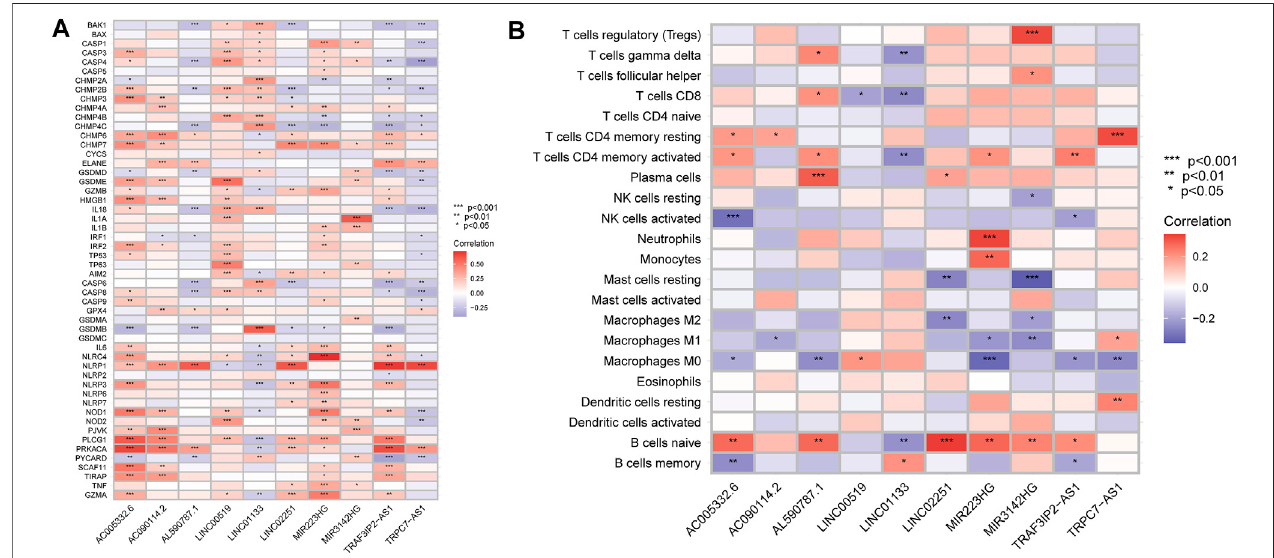
FIGURE9| Correlationanalysis. (A) CorrelationofPRlncRNAsandPRGs. (B) CorrelationofPRlncRNAsandimmunecells.Redreferstopositiverelationwhileblue refers to negative relation (* p < 0.05; ** p < 0.01; *** p < 0.001).